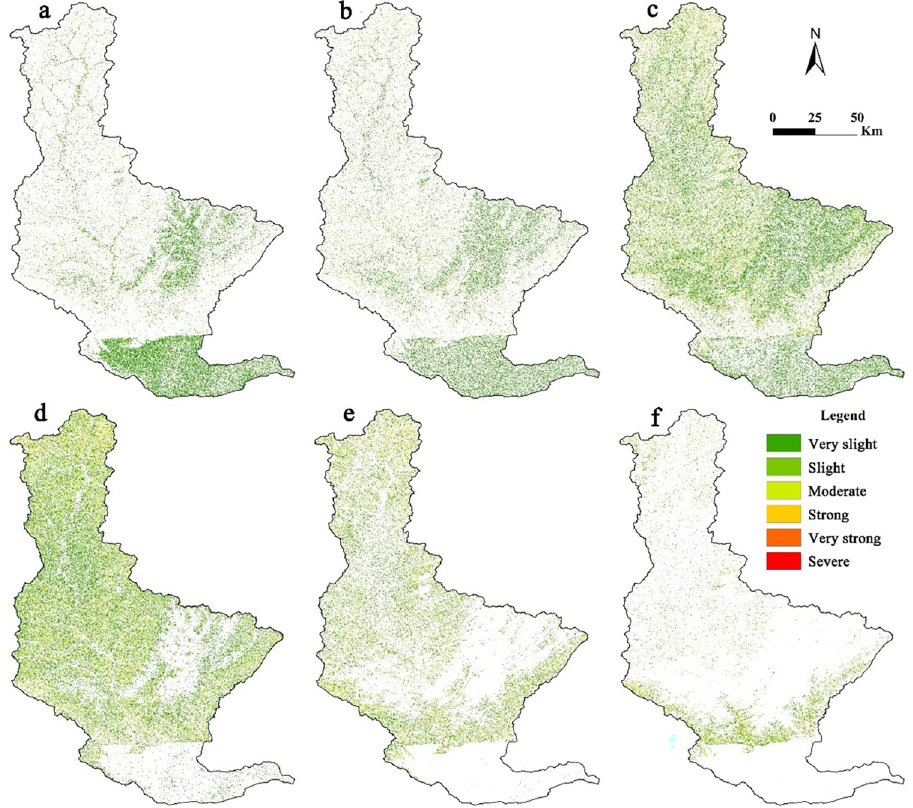
Fig 5. Distribution of the intensity of soil erosion at regions with varying slopes in the Qin River Basin. Slop � 5˚ (a); 5˚ < Slop < 8˚(b); 8˚ � Slop � 15˚(c); 15˚ � Slop < 25˚(d); 25˚ � Slop < 35˚(e); Slop � 35˚(f). Based on the superposition analysis function of the ArcGIS software, we extracted the slopes of the Qin River Basin, and divided them into 6 categories according to the gradient classification standards. The six types of slope maps and soil erosion maps were masked to obtain soil erosion classification maps of different slopes. The scope of the Qin River Basin was determined based on DEM and eight-direction (D8) algorithm. Based on authors’ field investigation, we have modified and adjusted the vector